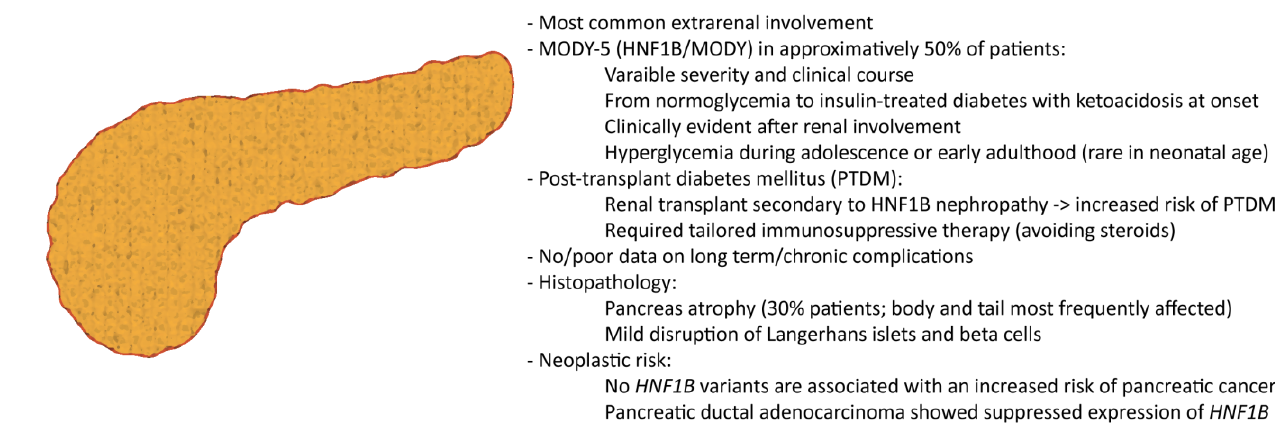
Figure 3. The HNF1B deficiency and the pancreas.